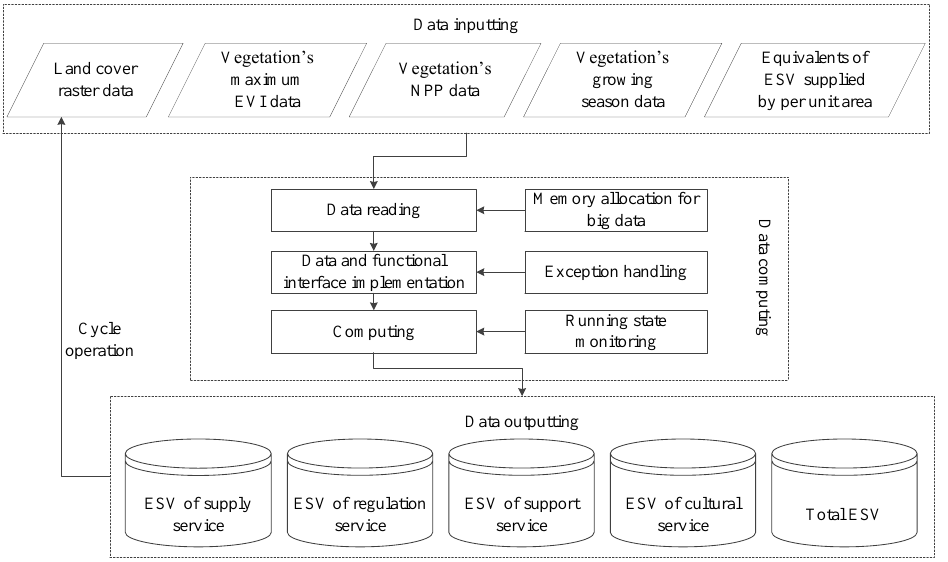
Figure 2. Model design of ESV big data calculating